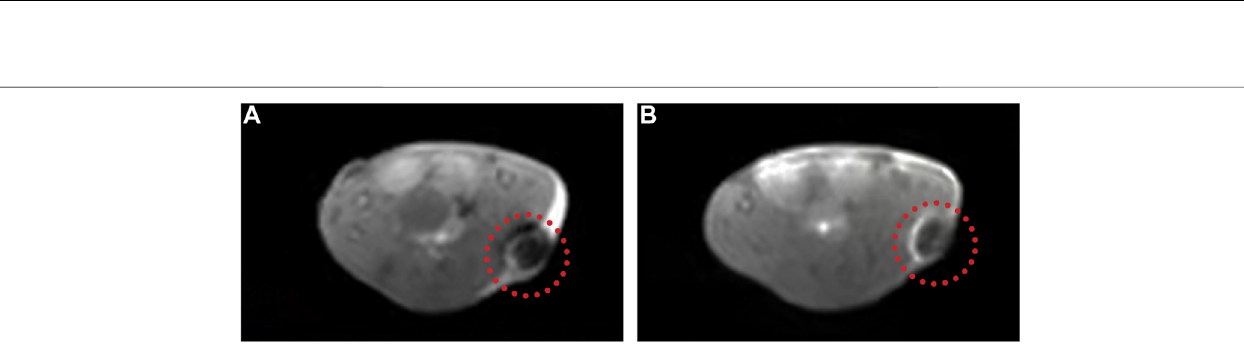
Frontiers in Bioengineering and Biotechnology |